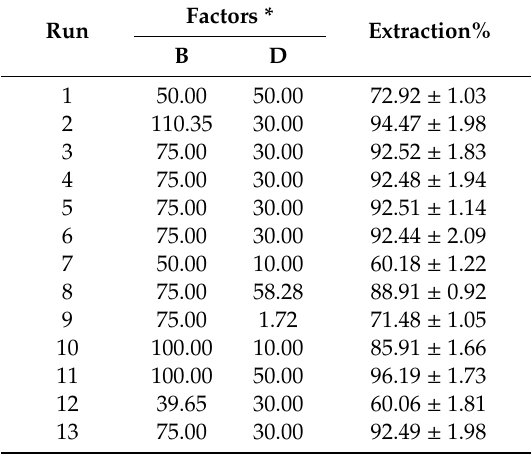
Table 4. Central composite design for optimization of Cd(II) ions extraction (diluent: toluene; mixing time: 10 min; operating temperature: 28 ± 1 ◦ C; TBP: 50 mM; mixing speed: 150 rpm; M i : 100 mg / L; pH eq : 5; O:A ratio = 1:1).